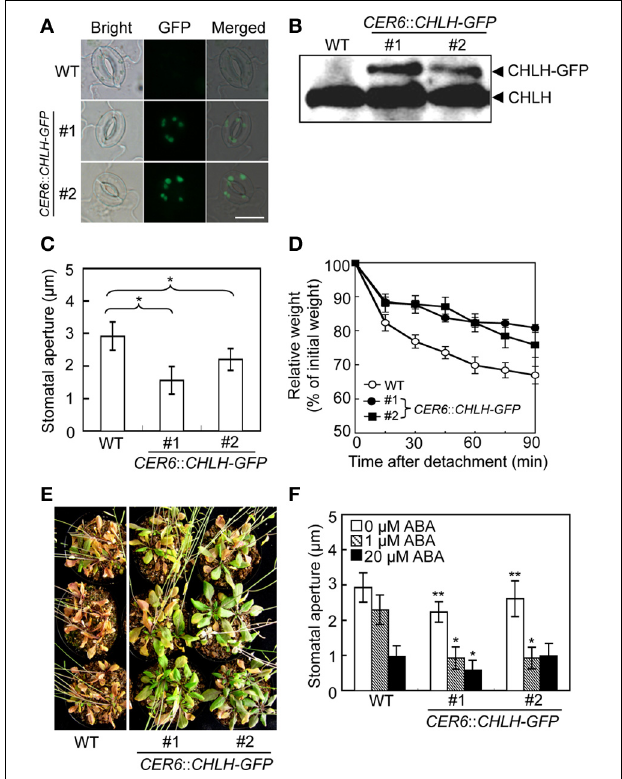
FIGURE 3 | Phenotypic analysis of CHLH transgenic plants. The phenotypes of two independent CER6::CHLH-GFP plants were compared with that of WT plants. (A) Typical bright-field and GFP fluorescent images of stomata in the abaxial epidermis of rosette leaves. Scale bar = 10 µ m. (B) Immunoblots using anti-CHLH antibody showing CHLH-GFP and endogenous CHLH in GCPs. (C) The stomatal aperture in 4-week-old plants exposed to light conditions at zeitgeber time (ZT) 4. Epidermal fragments were isolated from rosette leaves and apertures measured immediately. Data represent the means of 25 measurements ± SDs. Pairs for Student’s t -test are indicated with brackets ( ∗ P < 0 . 01). (D) Kinetics of fresh weight changes in detached rosette leaves from 4-week-old WT plants (open circles) and CER6::CHLH-GFP #1 (closed circles) and #2 (closed squares). The relative weights of leaves are presented ( ± SD ) as percentages of initial weights, being the weights of rosette leaves immediately after detachment from plants ( n = 6). (E) Drought tolerance in WT and CHLH-GFP transgenic plants. Plants grown in soil for 3 weeks were subjected to drought stress by withholding water for 18 days. (F) Effect of ABA on the stomatal aperture of WT and CHLH-GFP transgenic plants. Epidermal fragments isolated from rosette leaves of 4-week-old plants exposed to light at ZT 4 were treated with ABA at the indicated concentrations for 2.5h under BL superimposed on background red light. The stomatal apertures in the abaxial epidermis were measured microscopically. Data represent the means of 25 measurements ± SD s. Asterisks indicate significant differences between wild type and each CHLH -transgenic plants under 0 µ M ABA ( ∗ P < 0 . 05; Student’s t -test). The experiment was repeated three times on different occasions with similar